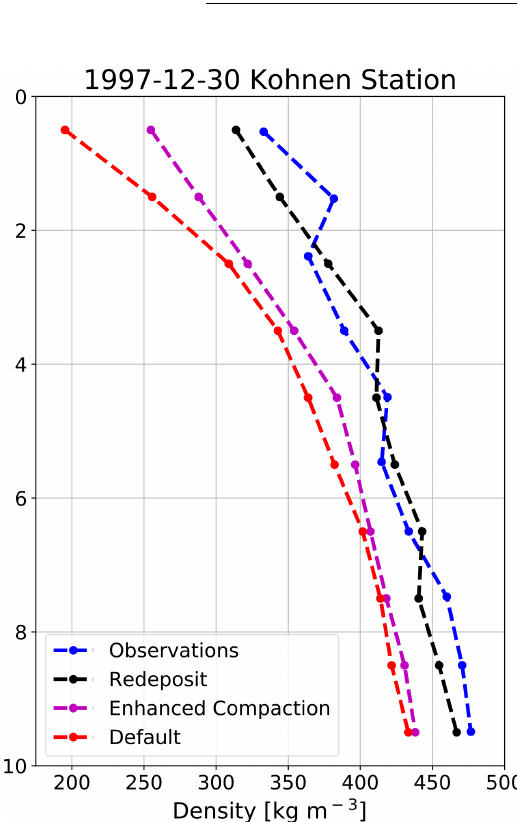
Figure 6. SNOWPACK-simulated density profiles’ sensitivity to prescribed snow physics. Observed (blue), SNOWPACK-simulated Redeposit (black), Enhanced Compaction (magenta), and Default (red) near-surface density profiles at Kohnen Station in Dronning Maud Land (75.0 ◦ S, 0.0 ◦ W,